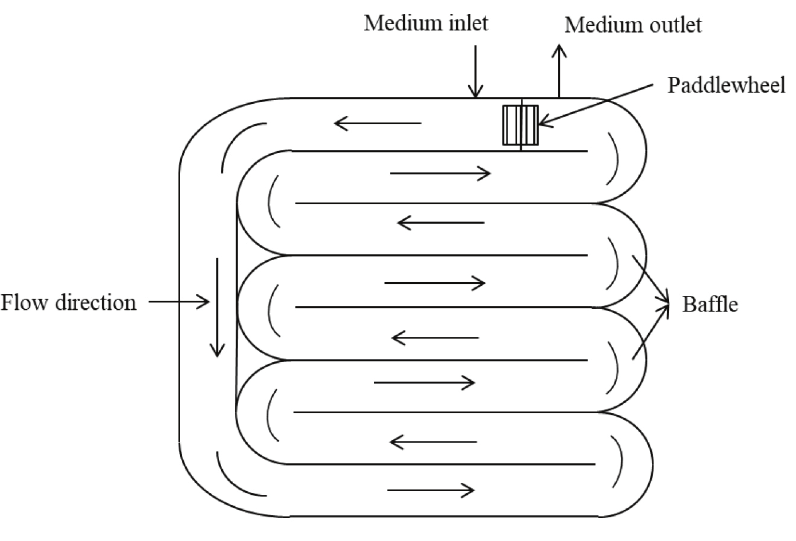
Fig. 1 – Scheme of a raceway pond (adapted from Christi 35